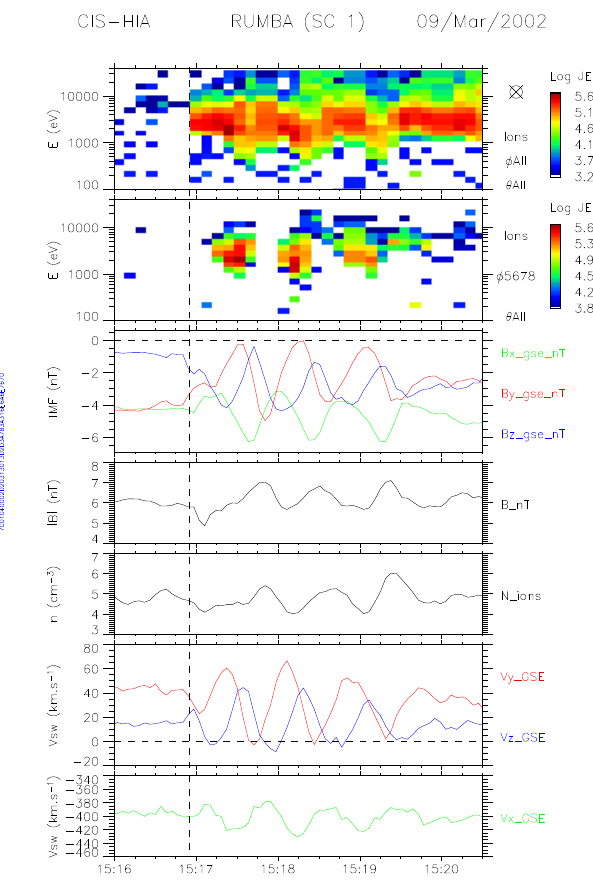
Fig. 1. The top two panels show, respectively, energy spectrograms from HIA-G integrated over all directions, and over the 145–235 ◦ azimuthal look directions; the third and fourth panels display the GSE components and magnitude of the IMF; and the last three pan- els present solar wind densities and GSE velocities from HIA-g. The dashed vertical line indicates the magnetic connection